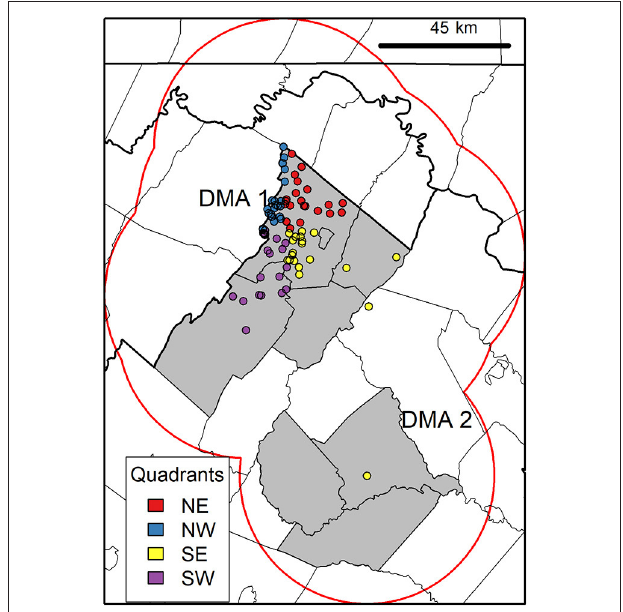
FIGURE 2 | Case study area delineation and current CWD distribution. Map shows the case study area outline (gray rectangle) that was determined using dissolved buffers (red line) of maximum dispersal distance (45km) (50) around positive cases (circles). Colored circles show quadrant organization of CWD positives ( n = 88) used in modeling in Virginia Department of Wildlife Resources Disease Management Areas (DMA) 1 and 2 (gray polygons). This case study area was used for acquiring landscape information (see modeling workflow in Figure 3